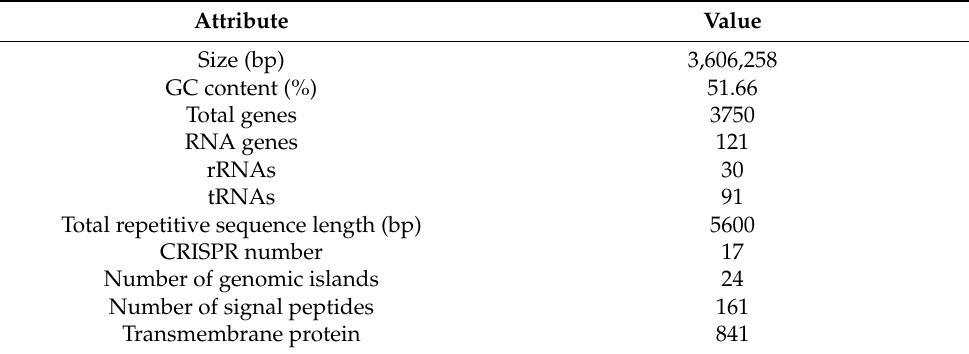
Table 2. General genomic characteristics of G. stearothermophilus H6.